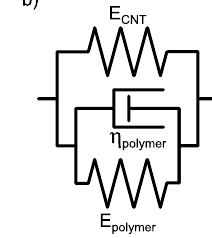
Figure 13. Schematical sketch of the ( a ) CNT-polymer-composite adapted from [23] and ( b ) the applied material model using mechanical